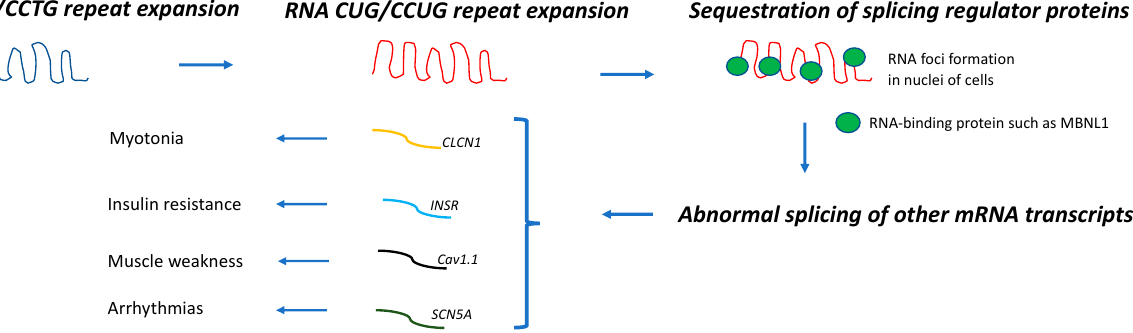
Figure 1. Pathogenic mechanism in DM. DNA repeat expansions are transcribed into mRNA molecules that accumulate in nuclei of cells and sequester splicing regulator proteins, such as MBNL1. As a result, abnormal splicing of a subset of other mRNA occurs, leading to different disease manifestations [6–10].